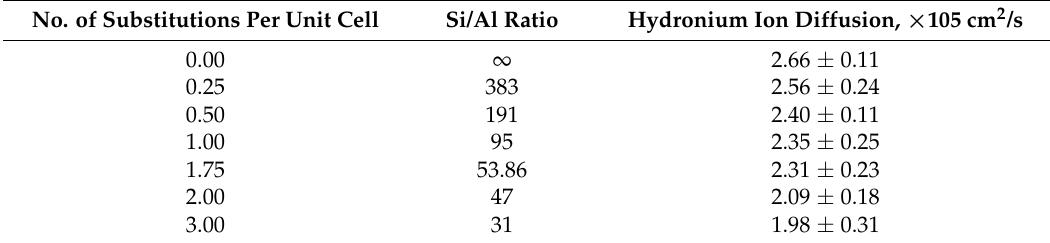
Table 2. Hydronium diffusion in membranes with increasing aluminum substitution